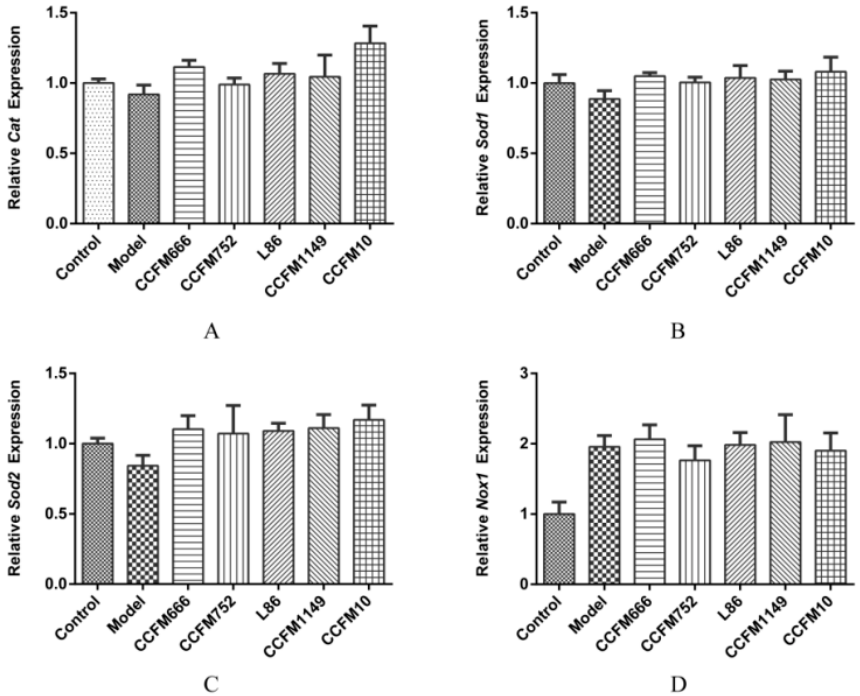
Figure 3. Relative transcriptional levels of genes in A7R5 cells. ( A ) Transcriptional levels of Cat . ( B ) Transcriptional levels of Sod1 . ( C ) Transcriptional levels of Sod2 . ( D ) Transcriptional levels of Nox1 . Values are shown as means ± SEM (n = 3).